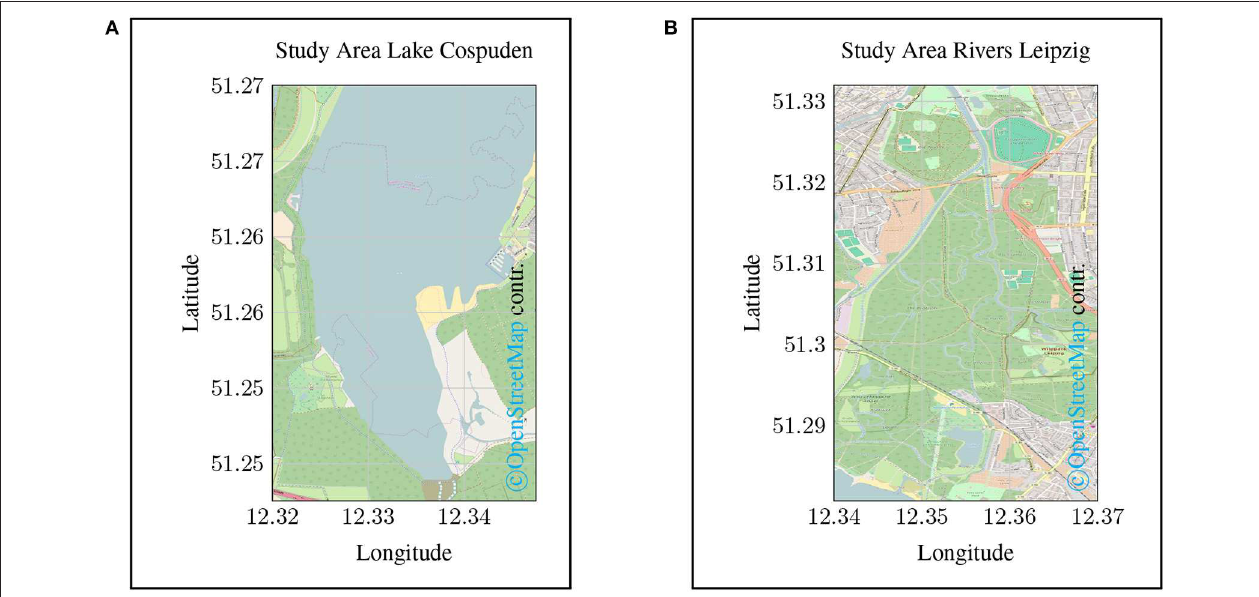
FIGURE 3 | Map of the study areas sampled in the case study. (A) shows the opencast mining lake Cospuden in the south of Leipzig. (B) shows the course of the Elstermühlgraben, a section of the Pleiße up to its confluence with the Elster near Leipzig.